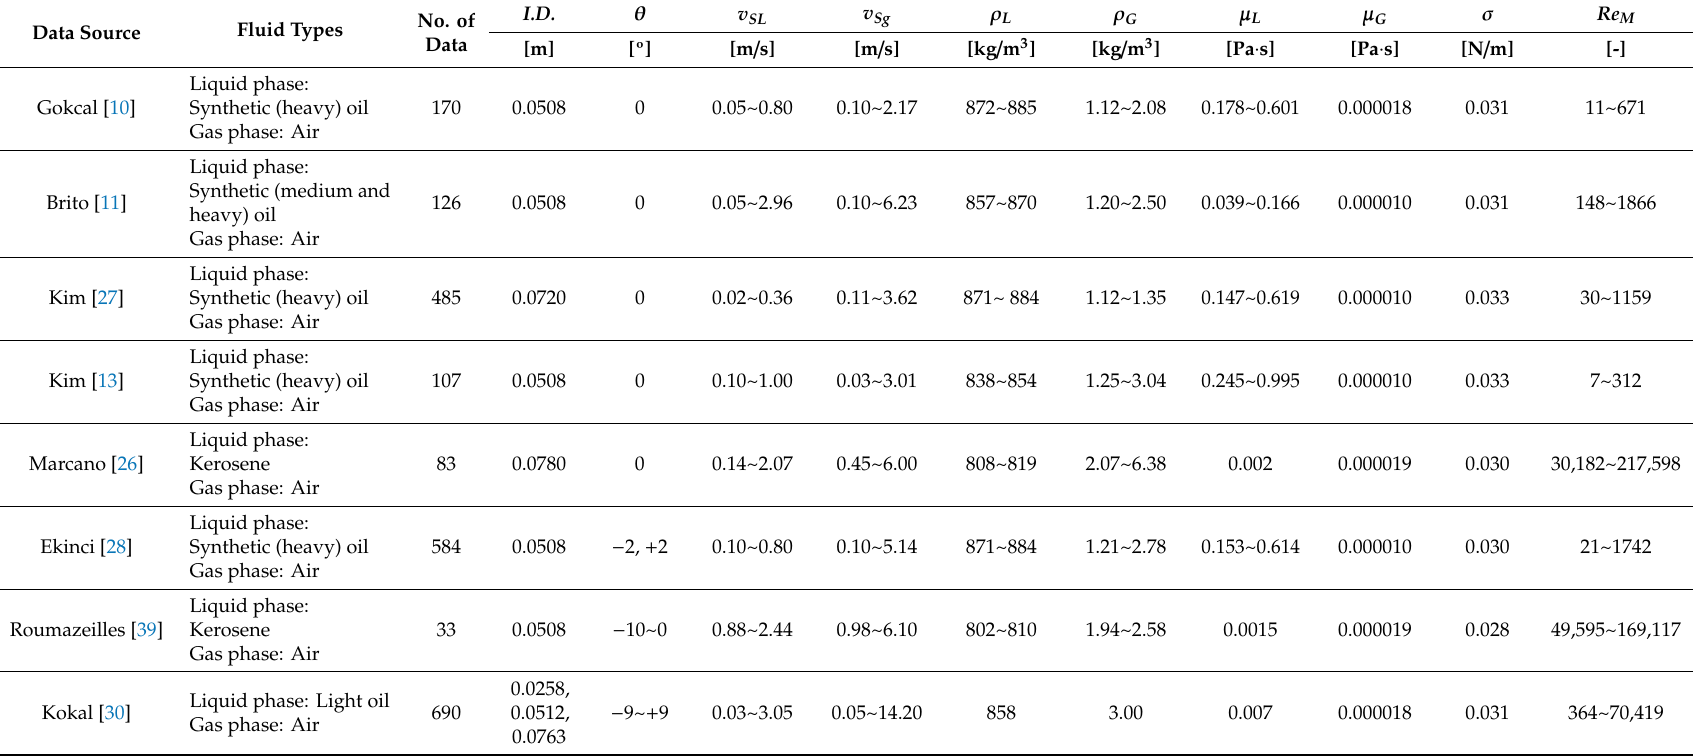
Table 1. Summary of translational velocity, v T ,